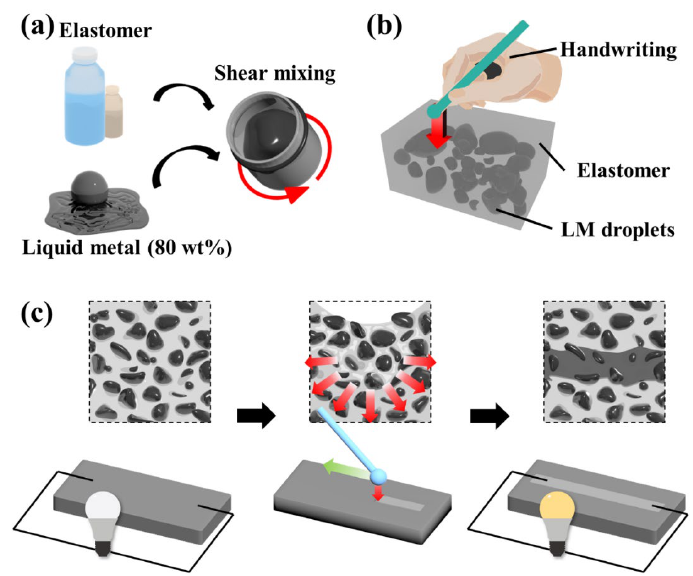
Figure 1. Schematics showing the fabrication process of the liquid metal elastomer film with a hand-written circuit. ( a ) Shear mixing a silicone elastomer with the liquid metal, ( b ) thermally cured silicone elastomer with the liquid metal droplets dispersed, and ( c ) conductive trace by sintering the liquid metal droplets via applying localized mechanical pressure onto the liquid metal elastomer film.